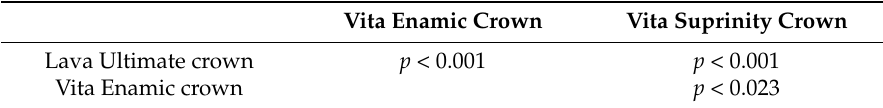
Table 5. Results of the Mann-Whitney U test comparing of the median value of the total occlusal abrasive wear (volume loss) of the full ceramic CAD/CAM crowns between the tested material groups. Results of the comparison of the total abrasive wear between all of the materials. Vita Enamic Crown Vita Suprinity Crown Lava Ultimate crown p < 0.001 p < 0.001 Vita Enamic crown p < 0.023